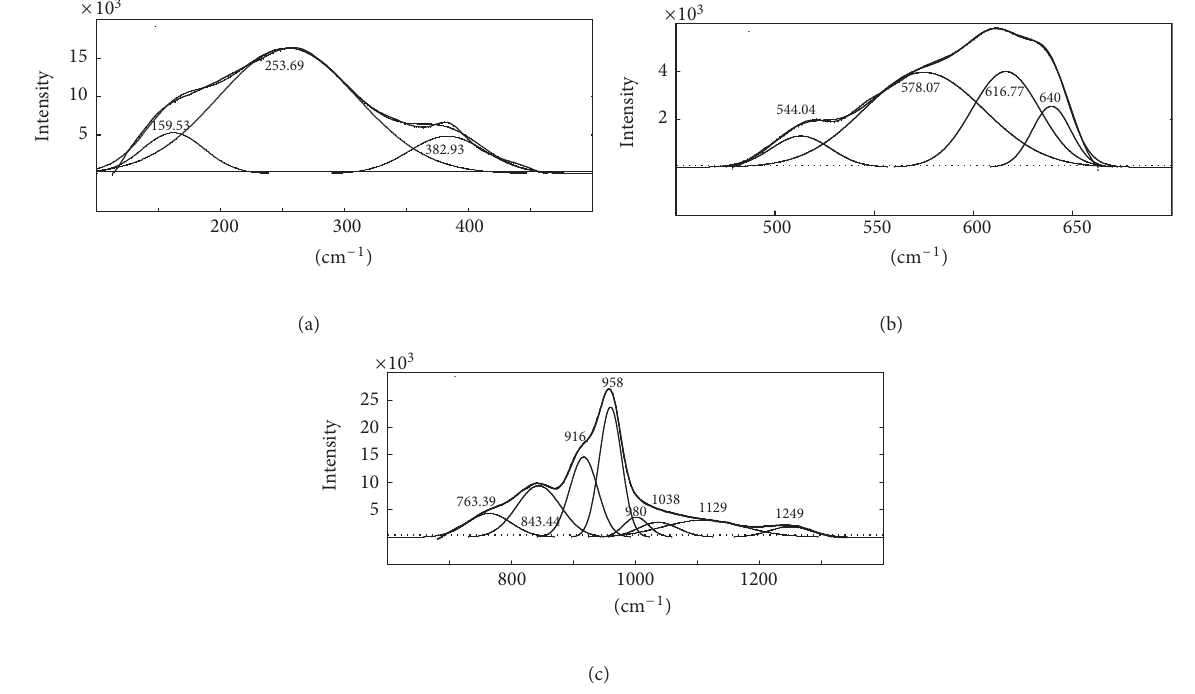
F 6: Deconvolution of the NaW-40 Raman spectrum in three frequency regions: (a) low, (b) medium, and (c)